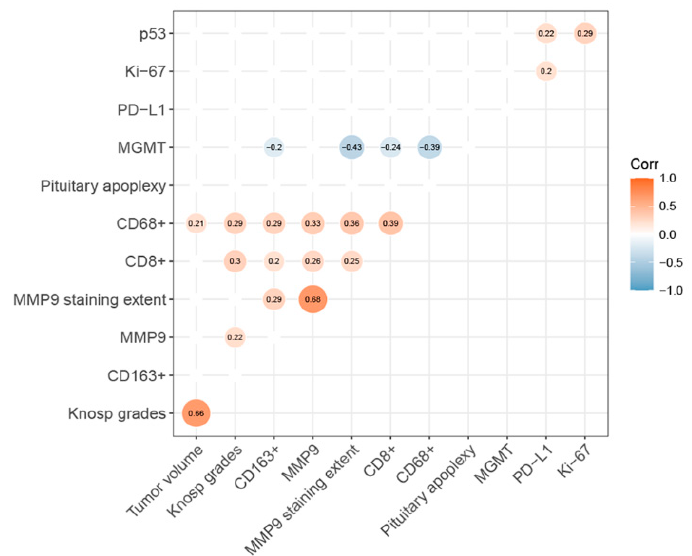
Figure 1. Immunohistochemistry of tissue microarray for immune cells in pituitary adenoma (PA). The different distribution of CD8+ TILs between the non- aggressive PA and aggressive PA at ×400 magnification ( a ) and the Knosp grades ( b ); the different distribution of CD68+ macrophages sur- rounding the vessels between the non-aggressive PA and aggressive PA at ×400 magnification ( c ) and the Knosp grades ( d ); the different distribution of the density of infiltrating CD163+ macrophages be- tween the non- aggressive PA and aggressive PA at ×400 magnification ( e ) and the Knosp grades ( f ).